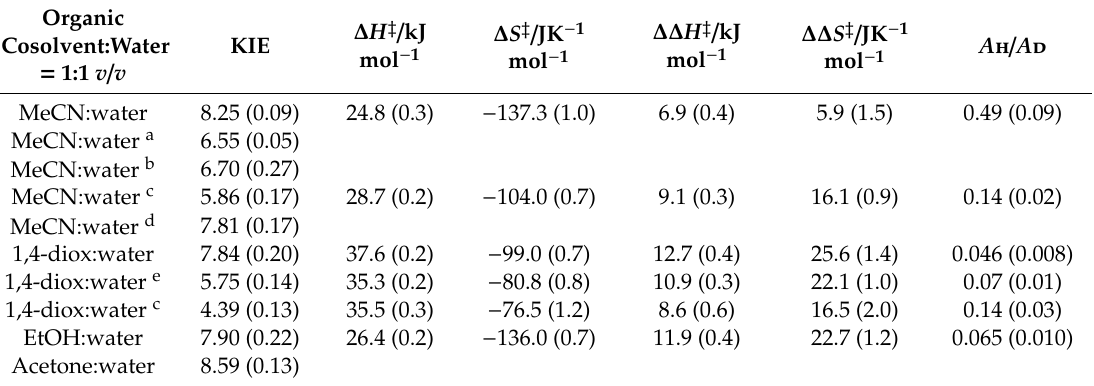
Table 2. Kinetic isotope e ff ects, activation parameters ∆ H ‡ and ∆ S ‡ , isotopic di ff erences ∆∆ H ‡ (D,H) and ∆∆ S ‡ (D,H) and ratios A h / A d in the reaction of ascorbate with hexacyanoferrate(III) Ions in the mixed water-organic cosolvent systems. Adapted from